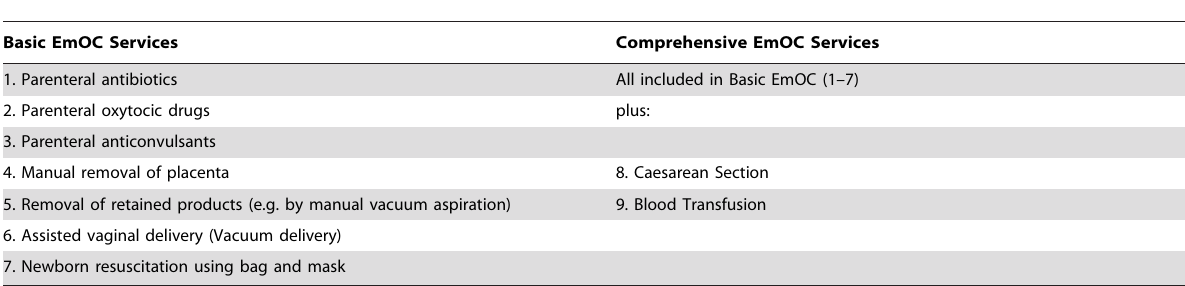
Table 2. Signal functions for Essential (or Emergency) Obstetric